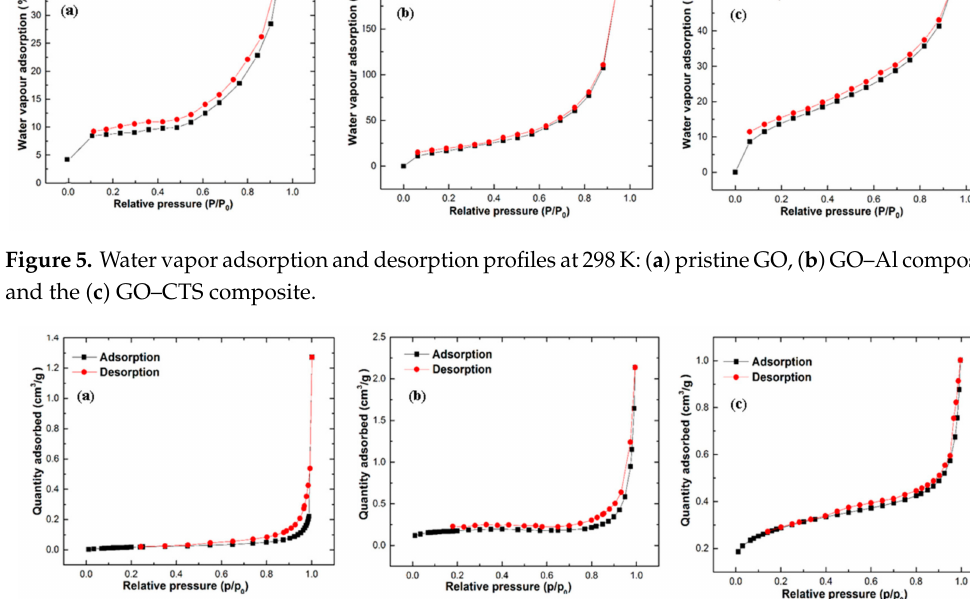
Figure 6. Nitrogen adsorption and desorption isotherm at 77 K: ( a ) pristine GO, ( b ) GO-Al composite, and the ( c ) GO–CTS composite.